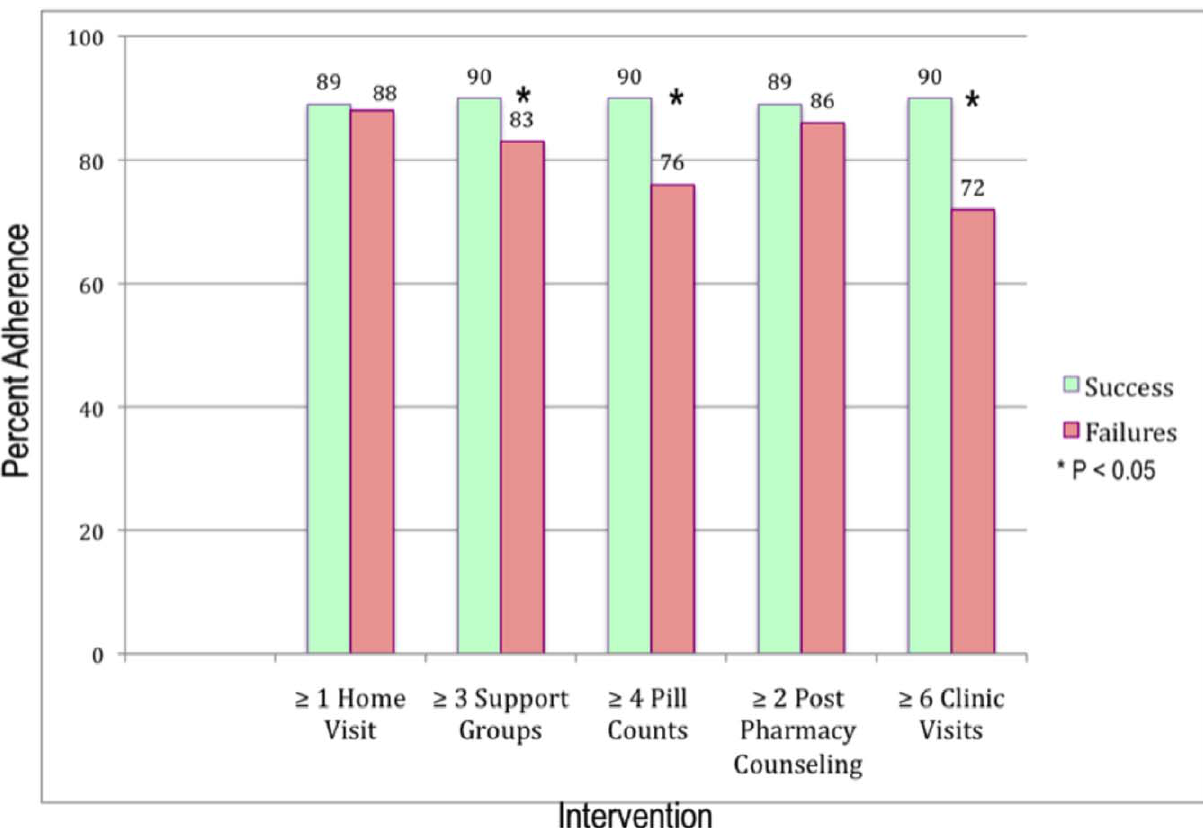
Figure 2. Rates of Adherence Categorized by Interventions. Rates of adherence in treatment successes and failures is shown by each intervention: 1) greater than one home visit; 2) participation in two or more support groups; 3) having four or more unannounced pill counts by primary care provider; 4) having two or more counseling sessions by a pharmacist; 5) completing six or more clinic visits.